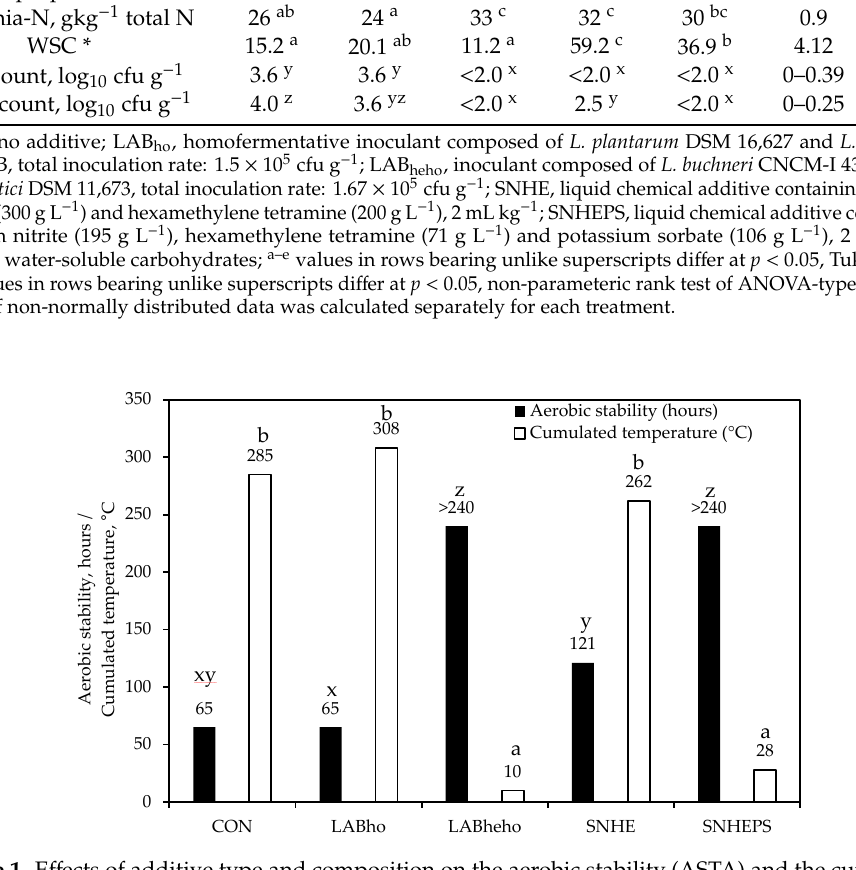
Figure 1. Effects of additive type and composition on the aerobic stability (ASTA) and the cumulated temperature (TCUM) in early-cut rye silage after 64 days of storage. CON, no additive; LAB ho , homofermentative inoculant composed of L. plantarum DSM 16,627 and L. paracasei NCIMB, total inoculation rate: 1.5 × 10 5 cfu g −1 ; LAB heho , inoculant composed of L. buchneri CNCM-I 4323 and P.